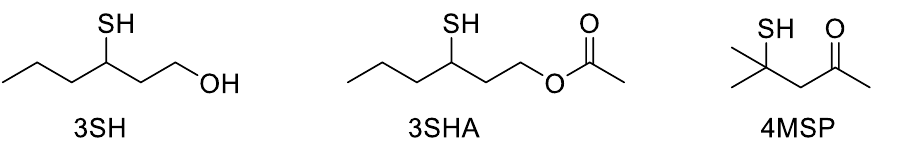
Figure 1. The three key volatile thiols in wine: 3-sulfanylhexan-1-ol (3SH), 3-sulfanylhexylacetate (3SHA), and 4-methyl-4-sulfanylpentan-2-one (4MSP).